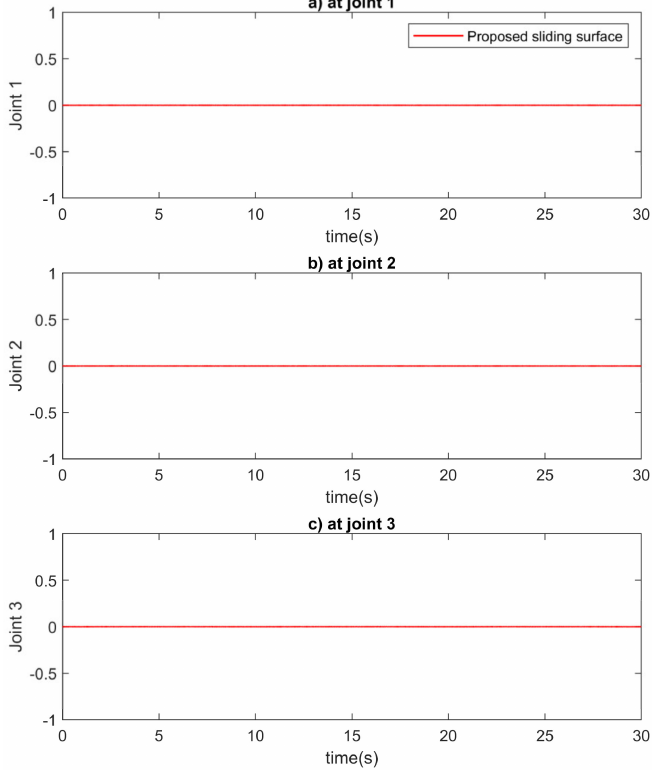
Figure 8. Time response of the proposed sliding surface at ( a ) joint 1, ( b ) joint 2 and ( c ) joint